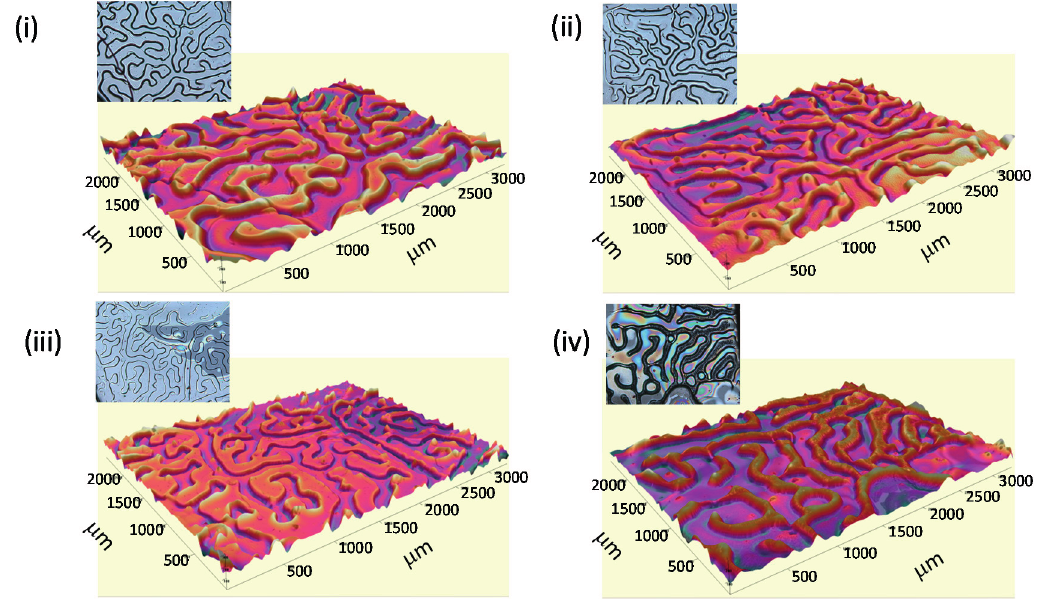
Figure 3. 3D images of the wrinkled surfaces prepared form blends having ( i ) 2, ( ii ) 5, ( iii ) 10, and ( iv ) 20 wt% of copolymer P(TFMA- co -MMA). Inset: Optical images of the